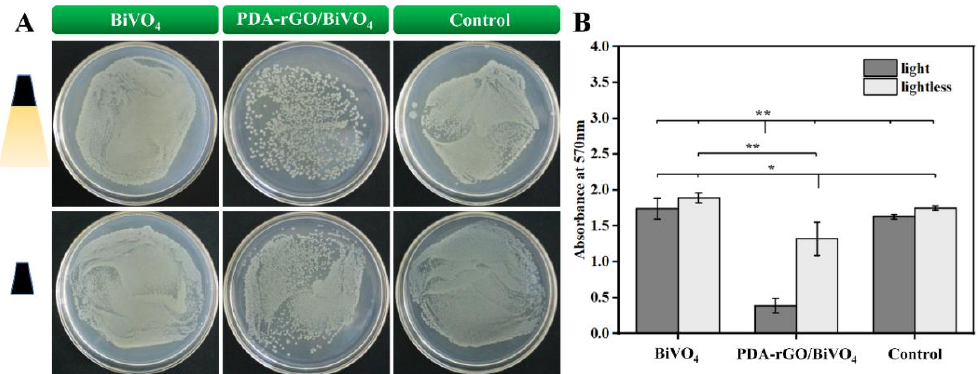
Figure 3. The antibacterial effect of PDA-rGO/BiVO 4 and BiVO 4 with or without xenon light irradi- ation was determined by flat colony counting ( A ) and MTT assay ( B ) (* p < 0.05 and ** p < 0.01 indicates significant difference).